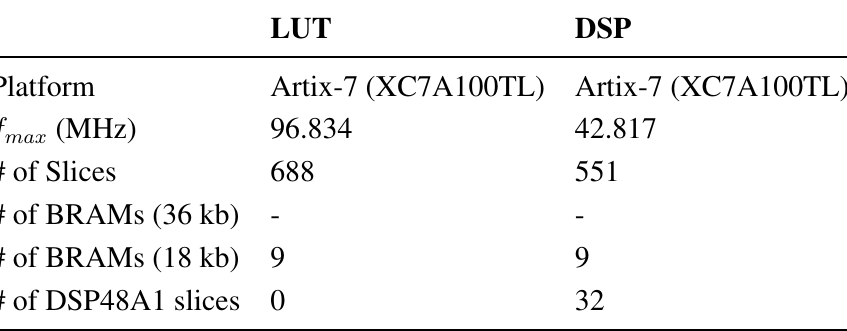
Table 6. PAR results of the SHA-256